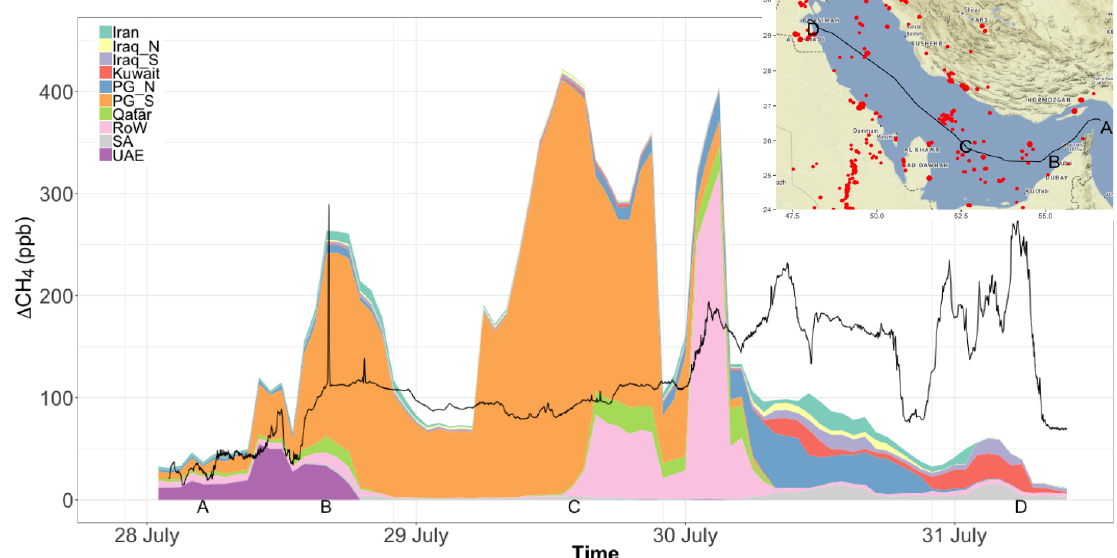
Figure 10. Simulation of (cid:49) CH 4 by country of origin over the Arabian Gulf. The solid line shows the measured DCH 4 . The simulated excess CH 4 is tagged and color coded by country or area of origin. The regions are indicated by the following abbreviations: Iraq_N is northern Iraq, Iraq_S is southern Iraq, PG_N is the northern half of the Persian (Arabian) Gulf, PG_S is the southern half of the Persian (Arabian) Gulf, RoW is the rest of the world, SA is Saudi Arabia, and UAE is the United Arab Emirates. The inset shows the trajectory of the ship corresponding to the simulation, and the labels A, B, C and D highlight points of the ship’s route discussed in the main text. Red points correspond to flaring detected from space (see Fig. 4) at the time of the campaign. Inset background map: © OpenStreetMap contributors 2021. Distributed under the Open Data Commons Open Database License (ODbL) v1.0.